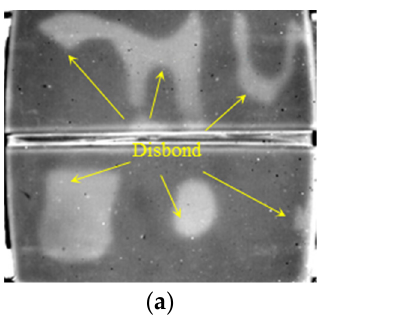
Figure 13. Detection results of disbond with 3 mm thick SIR. ( a ) The 1898th frame 1st DTI. ( b ) The 1046th frame 2nd DTI.